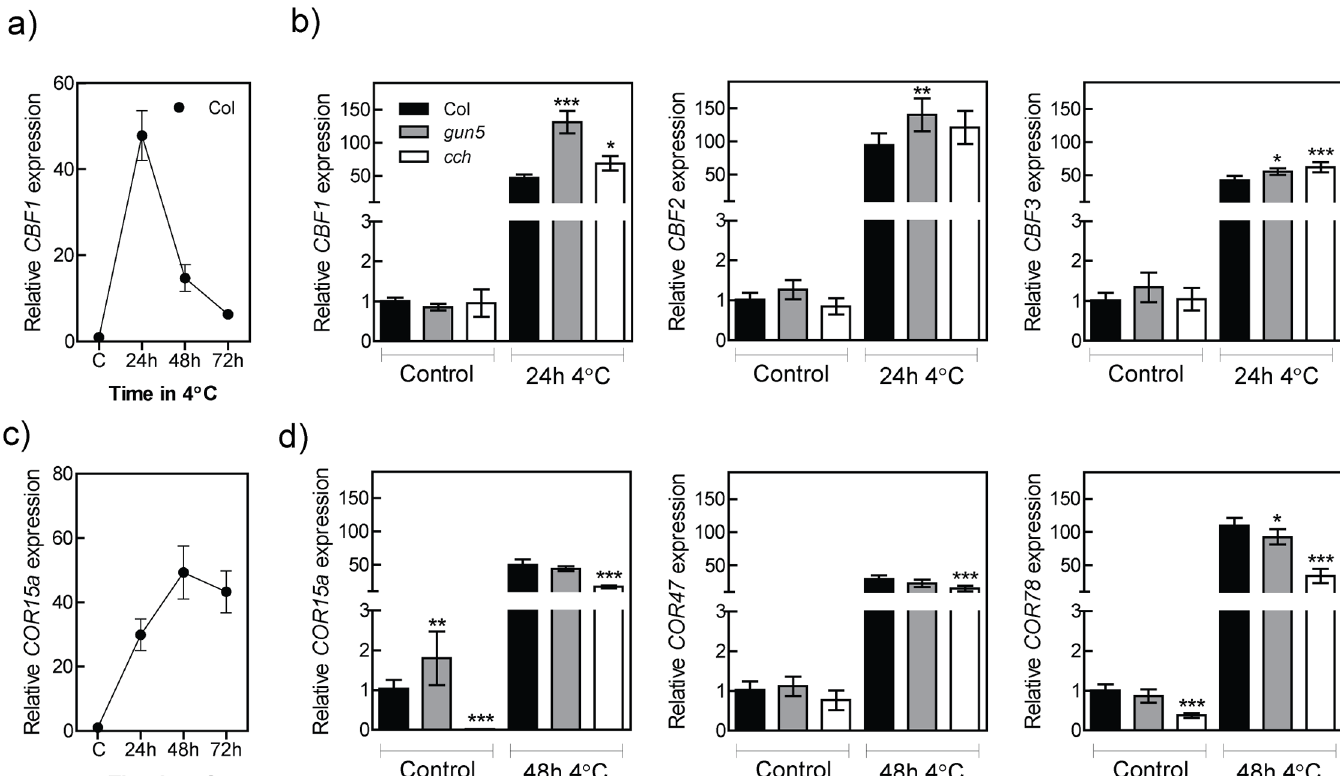
Fig 7. Transcript levels of CBF1-3 and their downstream target, COR15a in Col-0, gun5 and cch plants following cold exposure. 5-week old plants grown in SD conditions were transferred to SD conditions, 4°C, for indicated times. Extracted total RNA was DNase treated and cDNA synthesised. (a) Level of CBF1 (At4g25490) transcript in Col-0 following exposure to 4°C. (b) Levels of CBF1 , CBF2 (At4g25470) and CBF3 (At4g25480) transcripts in control conditions and after 24 hours of exposure to 4°C in Col-0, gun5 and cch plants. (c) Level of COR15a (At2g42540) transcript in Col-0 following exposure to 4°C. (d) Levels of COR15a , COR47 (At1g20440) and COR78 (At5g52310) transcripts in control conditions and after 48 hours of exposure to 4°C in Col-0, gun5 and cch plants. All transcript levels following exposure to 4°C were related to the transcript levels of respective grown control. Ubiquitin-like protein (At4g36800) was used as internal control. Data is from at least 3 independent replicates and show the mean ( ± SD). Significant differences was determined with two-way ANOVA with Bonferroni post-tests, p < 0.05 ( * ), p < 0.01 ( ** ), p < 0.001 ( *** ).